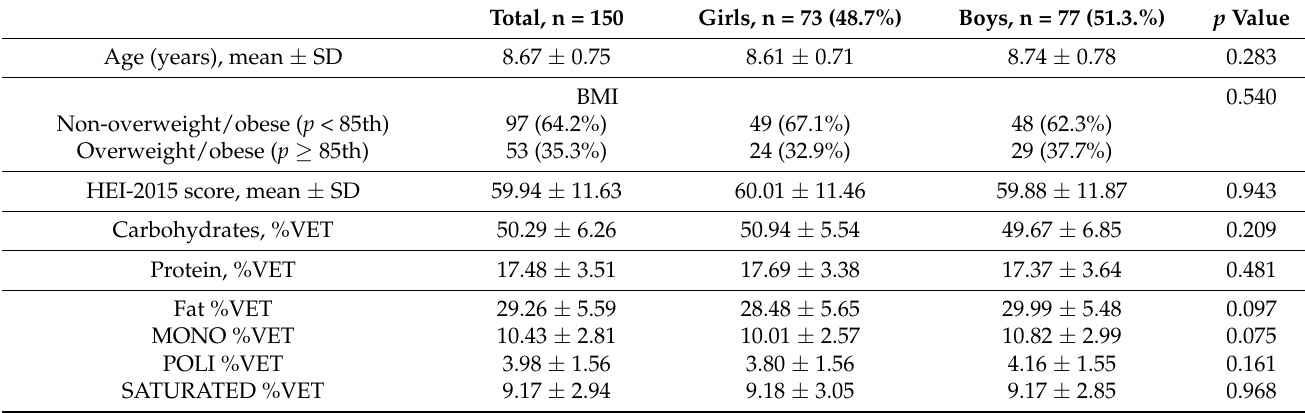
Table 1. Summary of participant’s